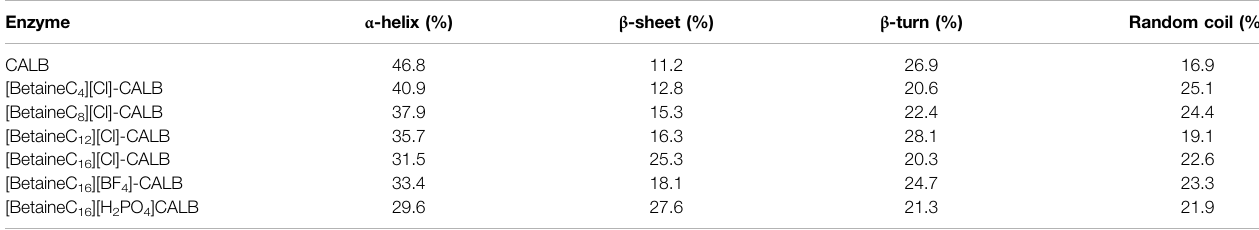
TABLE 3 | Secondary structure of enzyme and modi fi ed enzyme. Enzyme